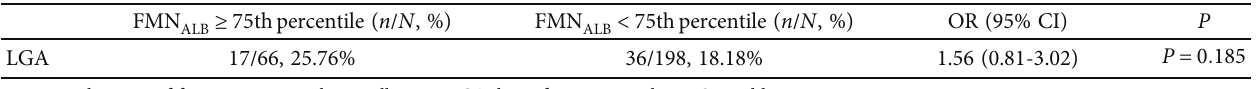
before delivery with the risk of LGA ALB